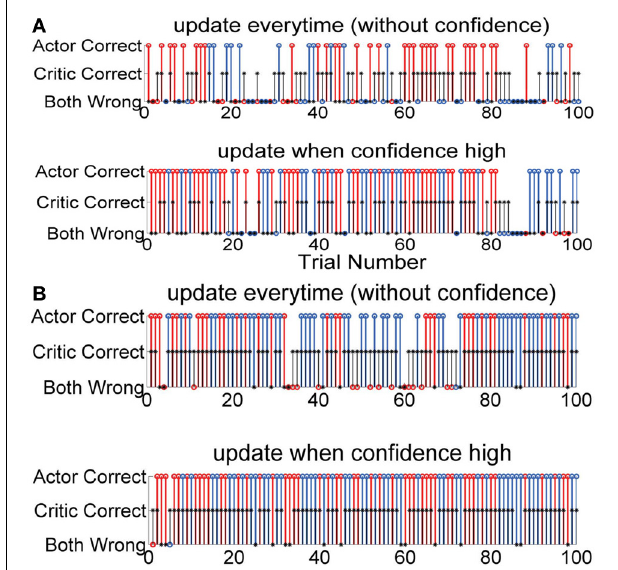
FIGURE 4 | Performance of each decoder during the length of the experiment for one simulation starting at random initial conditions. One hundred trials. Red: Action 1, Blue: Action 2, Black: Critic. (A) Critic accuracy 60%. Both decoders perform correctly in the first trial but the critic gives a wrong feedback. The first system changes the weights causing the second trial to be wrong. Again, the critic gives a wrong feedback causing the third trial also to be wrong. Since the system weights are updated every time, wrong critic feedback causes the system to perform below the critic accuracy. However, in contrast even though the second subplot also starts the first trial the same way, the erroneous feedback does not affect it and the decoder is able to perform better than the first system. (B) Critic accuracy 80%. The first system starts with a correct action, but is very sensitive to wrong critic feedback. The second system starts with a wrong action, but by the 6th trial is able to achieve good performance and maintain throughout the rest of the